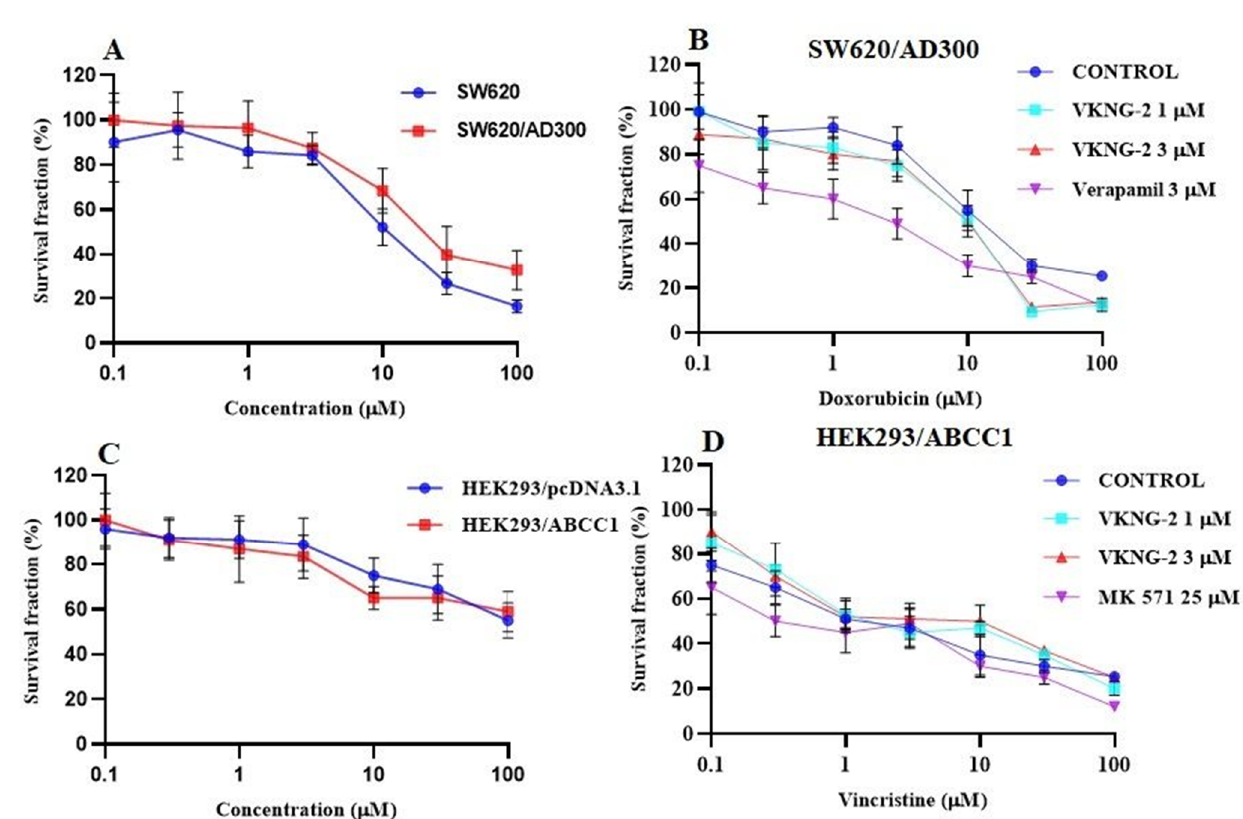
Figure 3. The effect of VKNG-2 in SW620 parental, ABCB1-overexpressing SW620/Ad300 colon cancer cells and HEK293/pcDNA3.1 parental and HEK293/ABCC1 transfected cells. ( A ) The survival fraction (%) for the SW620 parental and SW620/Ad300 colon cancer cell lines were determined following incubation with VKNG-2 for 72 h. ( B ) The IC50 values of doxorubicin in the presence of vehicle (Control), VKNG-2 (1 or 3 µ M) or verapamil (3 µ M) for 72 h in SW620 parental and SW620/Ad300 colon cancer cells. ( C ): The survival fraction (%) for the HEK293/pcDNA3.1 (empty DNA vector control) and HEK293/ABCC1 (transfected with the DNA coding for the ABCC1 transporter) cells were determined following incubation with VKNG-2 for 72 h. ( D ) The IC 50 values of vincristine in the presence of vehicle (Control), VKNG-2 (1 or 3 µ M) or MK-571 (25 µ M) for 72 h in HEK293/pcDNA3.1 and HEK293/ABCC1 cells. The points with error bars represent the mean ± SD of independent determinations in triplicate. The figures are representative of three independent